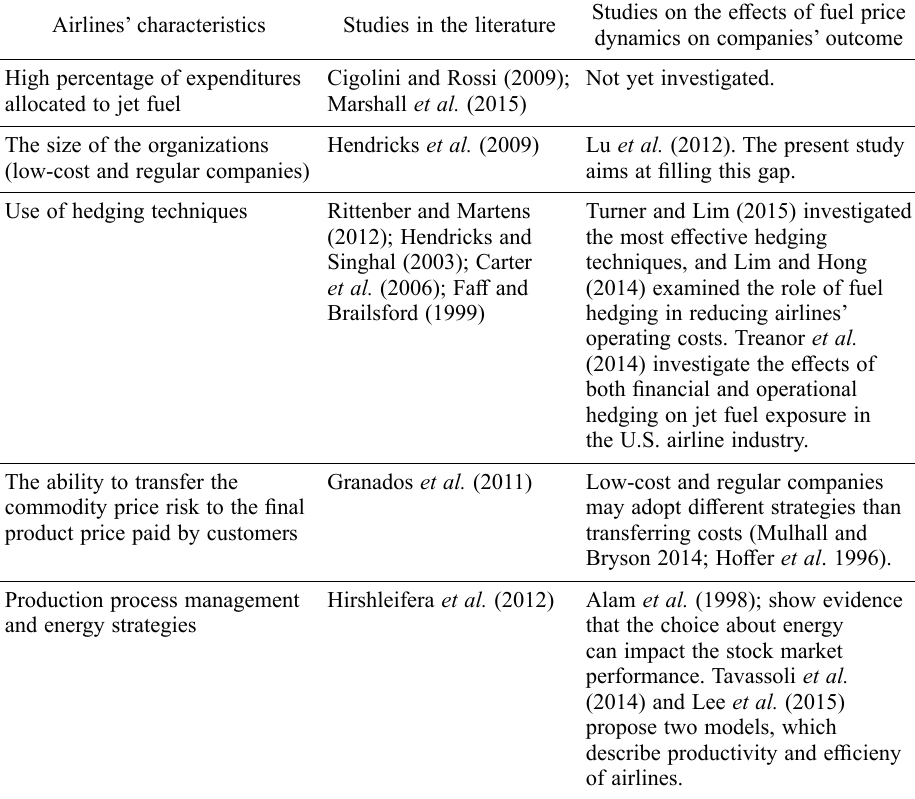
Table 2. Airlines’ characteristics and effects of fuel price